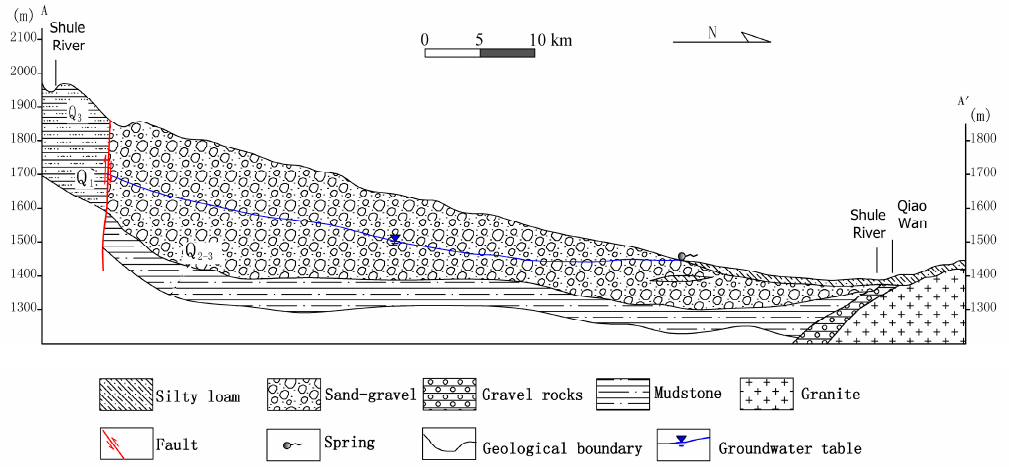
Figure 2. Hydrogeological cross section of the study area from the Qilian Mountains to the Beishan Mountains.